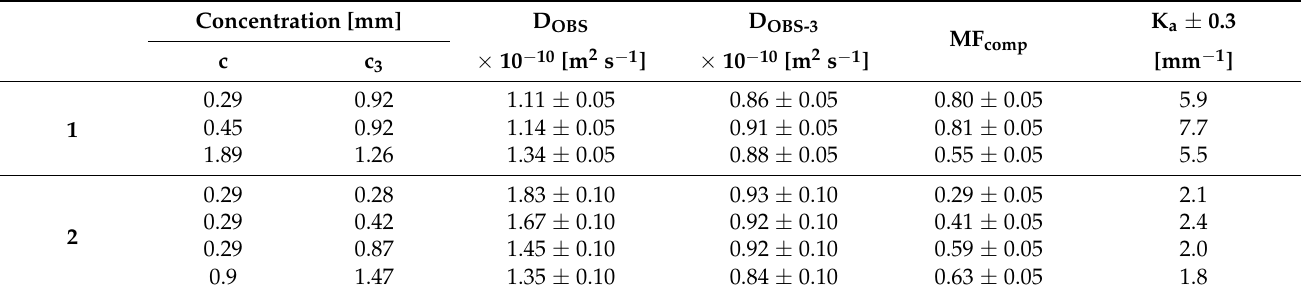
Table 3. The PGSE data for the binding of 1 or 2 with octamer 3 1 in D 2 O buffer (25 mM NaCl/25 mM K 3 PO 4 ), pH 6.4, temp. 10 ◦